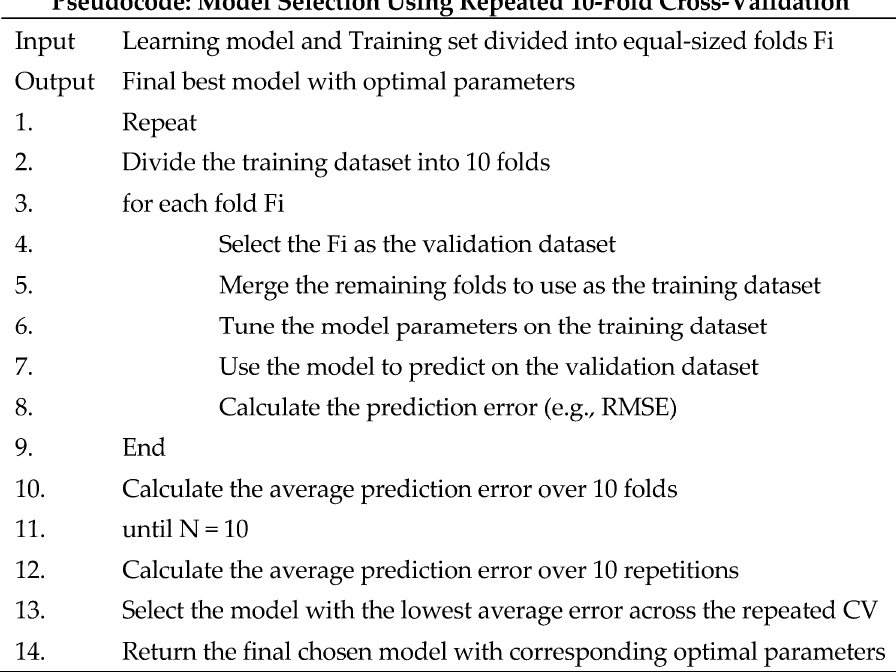
Figure 2. A pseudocode representation of the repeated 10-fold cross-validation (CV) process used for parameter optimization and model selection of ML algorithms.